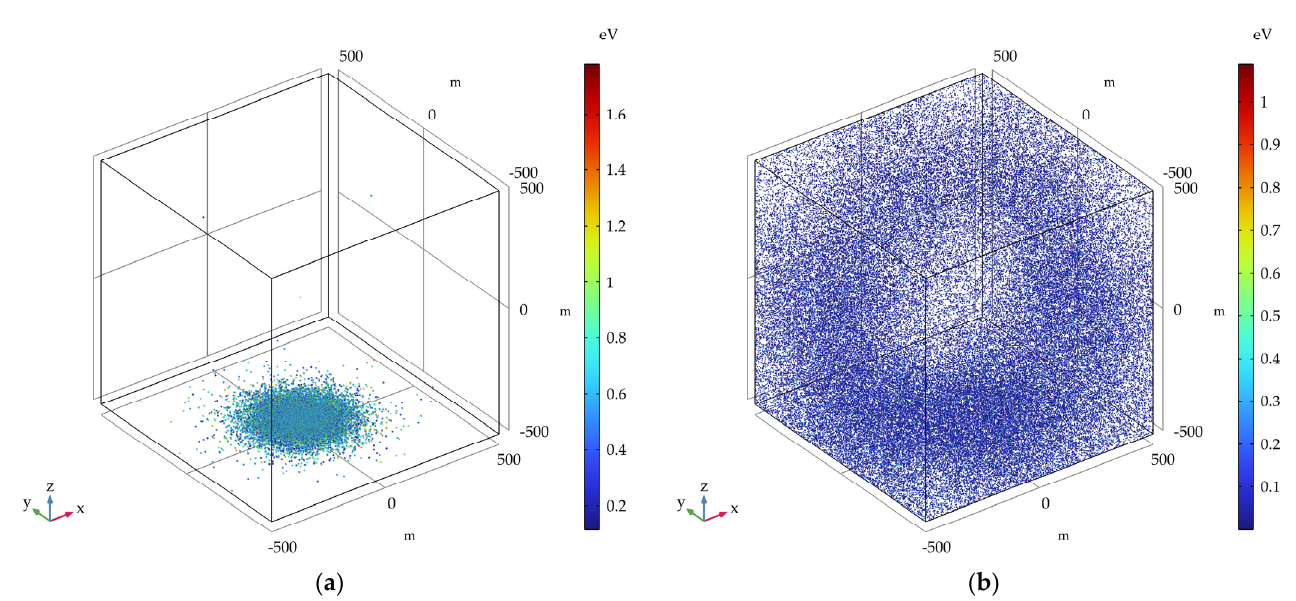
Figure 6. Simulation results of surface material outgassing in the MM case: ( a ) 120 km; ( b ) 320 km.